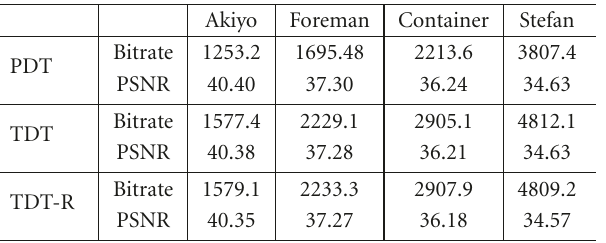
Table 1: RD performance comparisons with QP = 27. Bitrate: kbps, PSNR: dB.